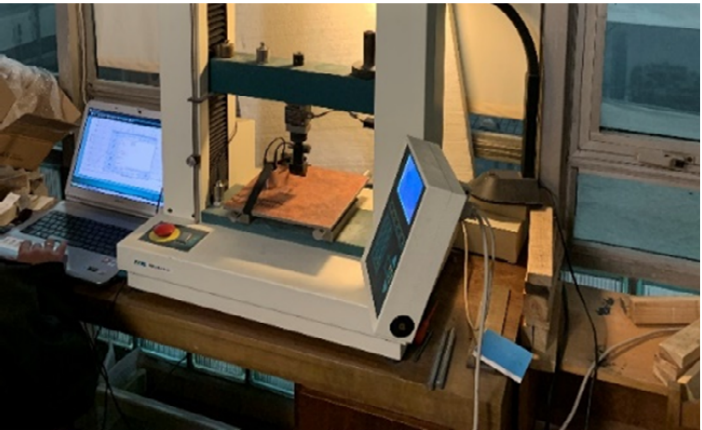
Figure 10. Three-point bending flexural testing machine. difference between the courses of the individual graphs for different samples is evident.